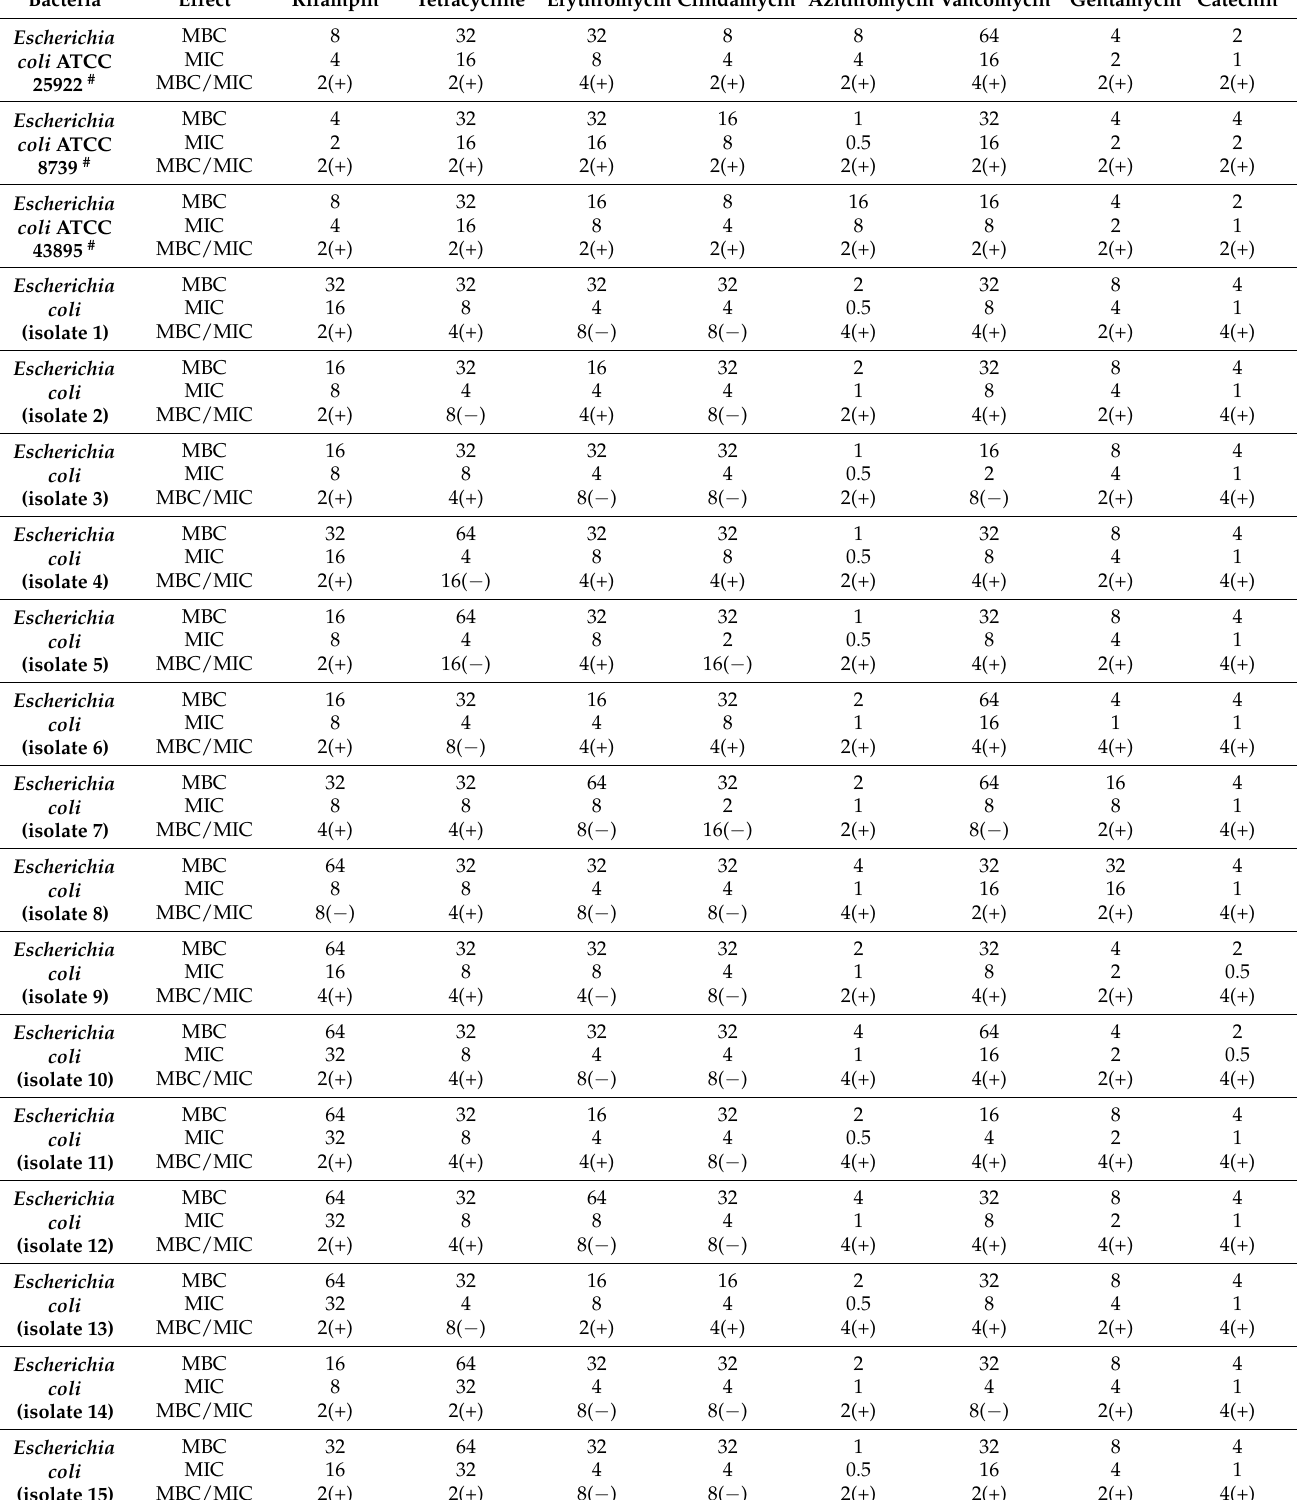
Table 2. Minimum bactericidal concentration (MBC) (mg/mL), minimum inhibitory concentration (MIC) (mg/mL), and MBC/MIC ratio for the antimicrobial agents and catechin against E. coli